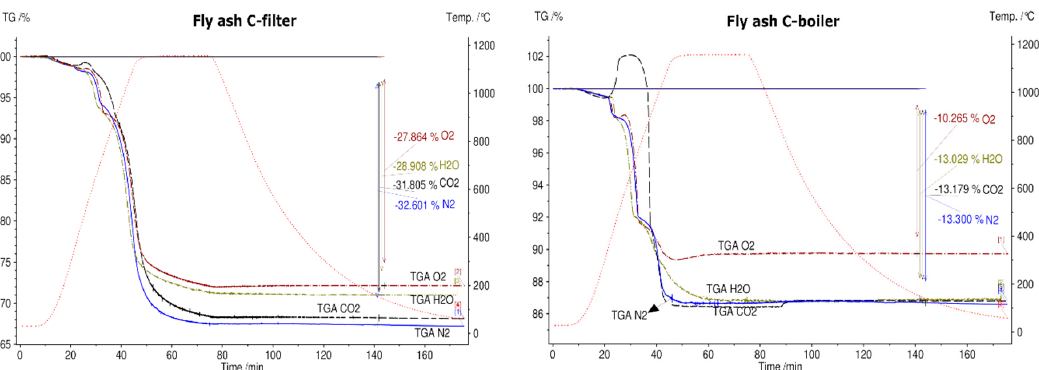
Figure 8. Thermogravimetric (TG) results for fly ash samples A , B , C -filter, and C -boiler in different